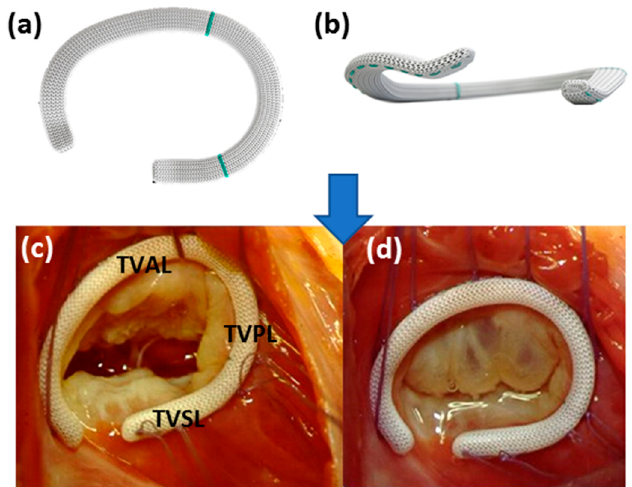
Figure 6. ( a ) Edwards physio-partial annuloplasty ring ( b ) mimics the three-dimensional geometry of the TV annulus. ( c ) The implanted annuloplasty ring is shown during diastole, and ( d ) systole. Images were modified from [92].